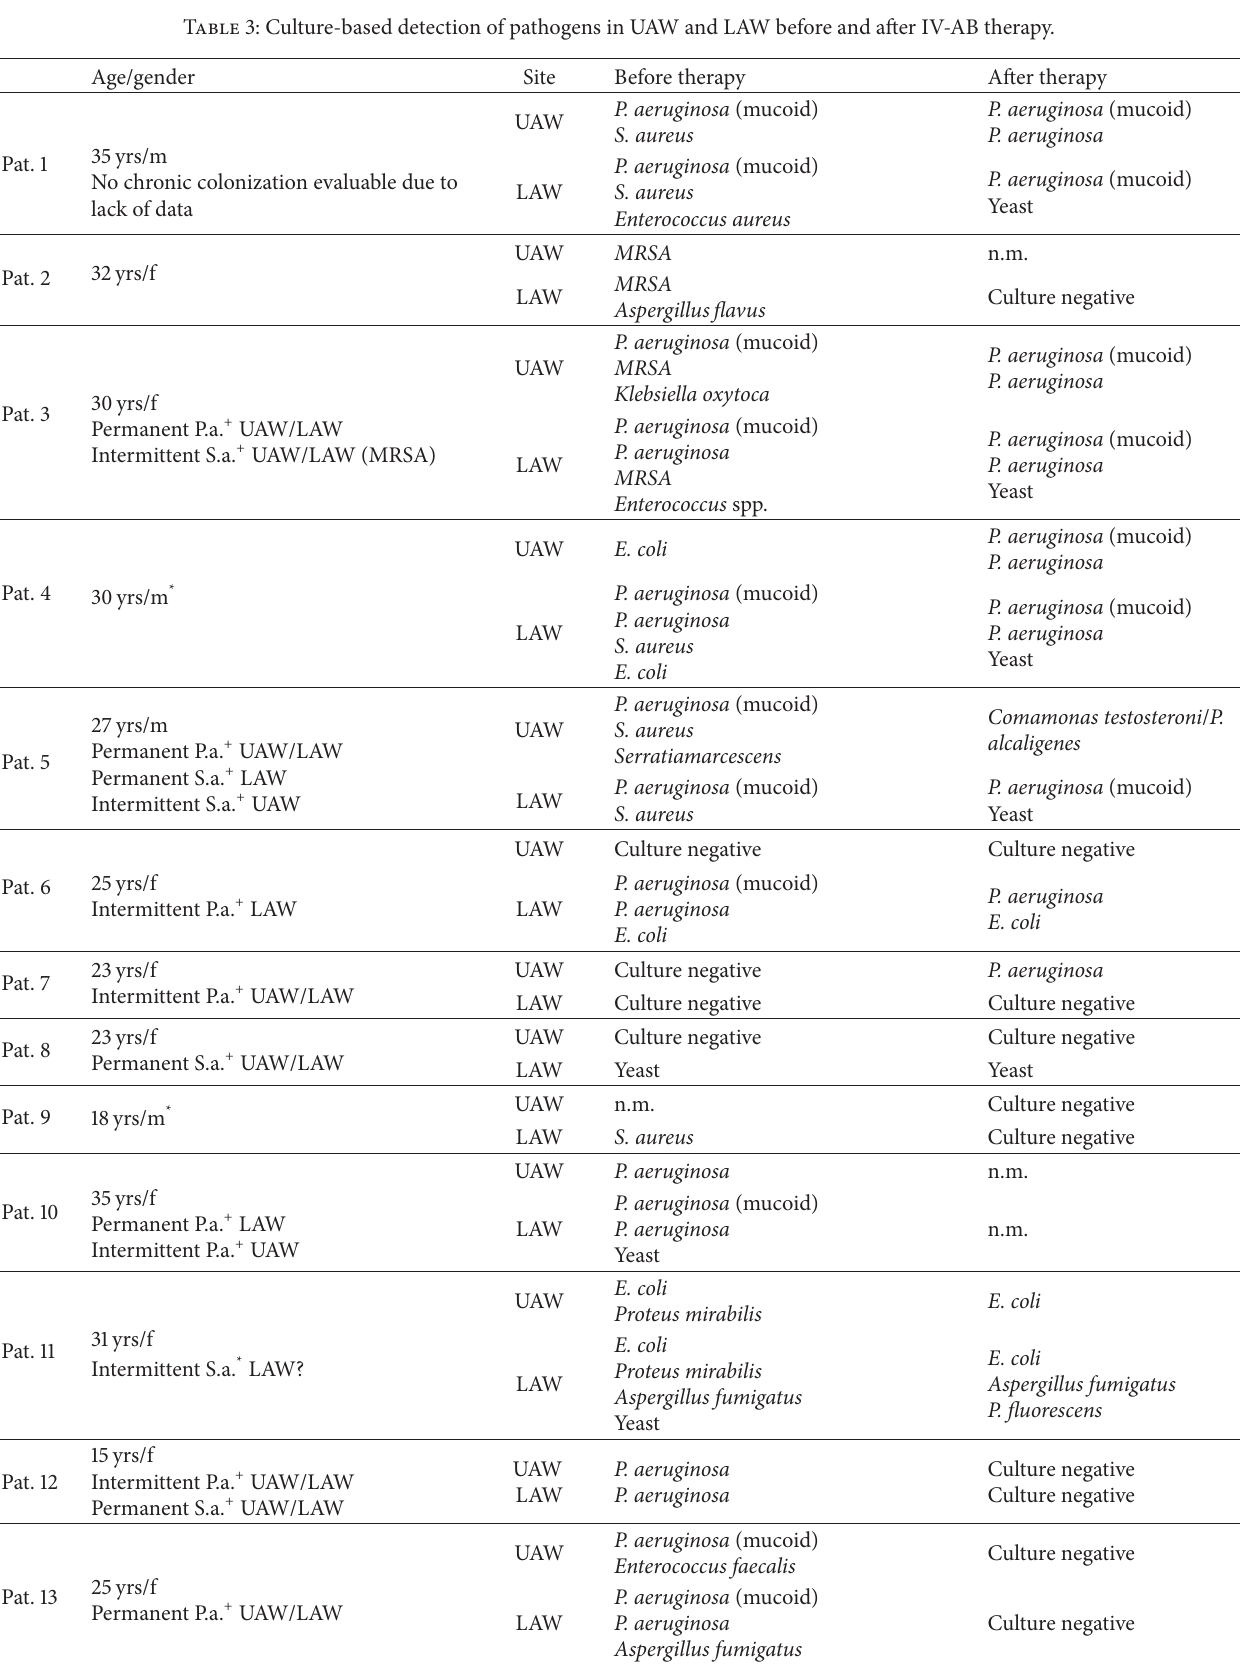
Table 3: Culture-based detection of pathogens in UAW and LAW before and after IV-AB